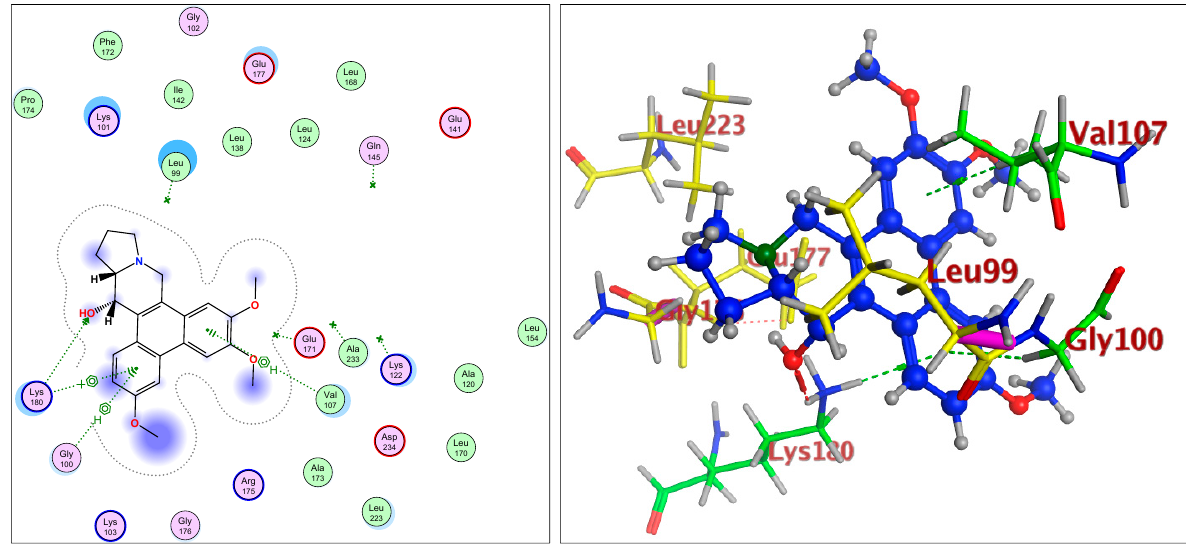
Figure 3. Overlay of compound ( 6 ) bound to the active site of ATP-binding pocket of Aurora-A. The participations of certain amino acids at the binding domains of the Aurora kinases were demonstrated. Compound ( 3 ) with pose 15, and energy binding requirements/stabilization energy at − 6.79 kcal/mol; compound ( 5 ) with pose 21, and energy requirements at − 7.45 kcal/mol; and compound ( 6 ) with pose 27, and energy requirements at − 7.24 kcal mol (compared with the score binding energy of ADP; the co-crystalline ligand of Aurora-A at − 8.32 kcal/mol) suggested their plausible geometric orientations, binding mode, and energy requirements for the better anticancer activity elicitation based on the molecular docking details as outlined (Figures 1–6, Table 2). The Aurora-A and B in vitro activity, IC 50 levels, for compounds ( 3 ), ( 5 ), and ( 6 ) were found to be 3.6 ± 0.93 μ M and 4.1 ± 1.08 (compound ( 3 ), Aurora-A and B, respectively); 1.3 ± 0.58 μ M and 0.6 ± 0.72 (compound ( 5 ), Aurora-A and B, respectively); and 6.5 ± 0.76 μ M and 2.6 ± 0.86 (compound ( 6 ), Aurora-A and B, respectively) (Table 3), again confirmed the levels and outreach of the active compounds.